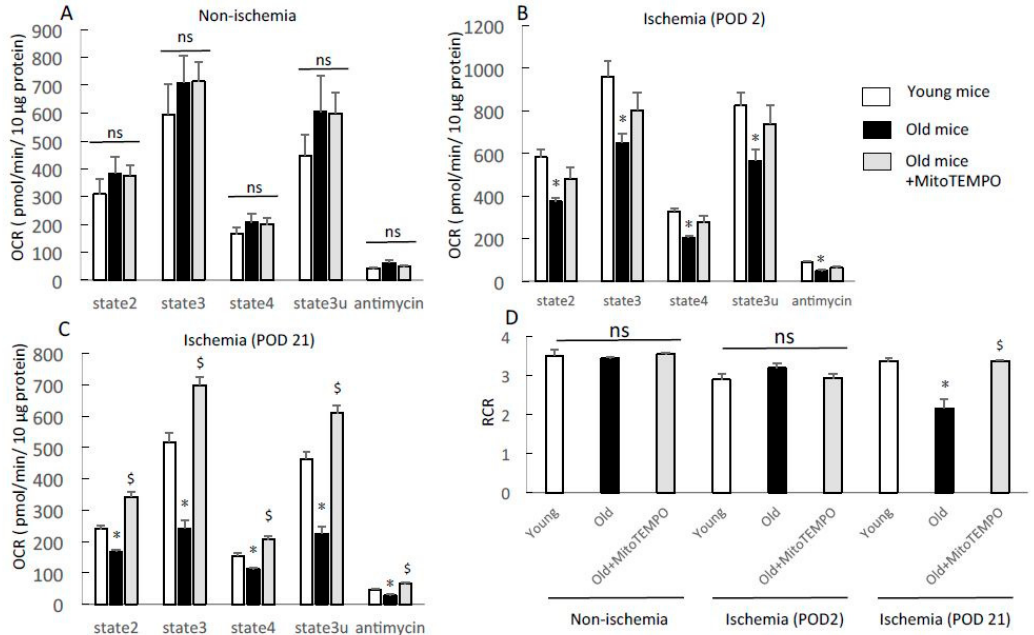
Figure 4. Respiration profile from isolated mitochondria in soleus. The mitochondrial respiration profile was assessed using the XF24 flux analyzer in non-ischemic and ischemic (POD 2 and 21) skeletal muscles of young, old, and MitoTEMPO-treated old mice. States 2, 3, 4, and 3u respiration and response to antimycin in non-ischemic skeletal muscles did not differ among the three groups of mice ( A ); states 2, 3, 4, and 3u respiration and response to antimycin in ischemic skeletal muscles (POD 2) were lower in old mice than that in young mice. MitoTEMPO treatment preserved mitochondrial respiration, though it was not significantly different ( B ); states 2, 3, 4, and 3u respiration and response to antimycin in ischemic soleus (POD 21) were lower in old mice than that of young mice. MitoTEMPO treatment preserved mitochondrial respiration ( C ); the respiratory control ratio (RCR: state 3/state 4 respiration in the presence of succinate) of ischemic soleus (POD 21) was lower in old mice than in young and MitoTEMPO-treated old mice, whereas that of non-ischemic and ischemic (POD 2) skeletal muscles did not differ among the three groups ( D ). The values are expressed as the means ± S.E.M. n = 10, each. * p < 0.05 vs. young mice, $ p < 0.05 vs. old mice. ns indicates no significant difference.